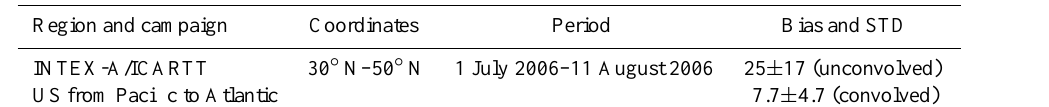
* There are no MOPITT V3 data matching NyAlesund, Spitsbergen surface measurements . In summer time, “day” and “night” at NyAlesund are conditional due to the long solar